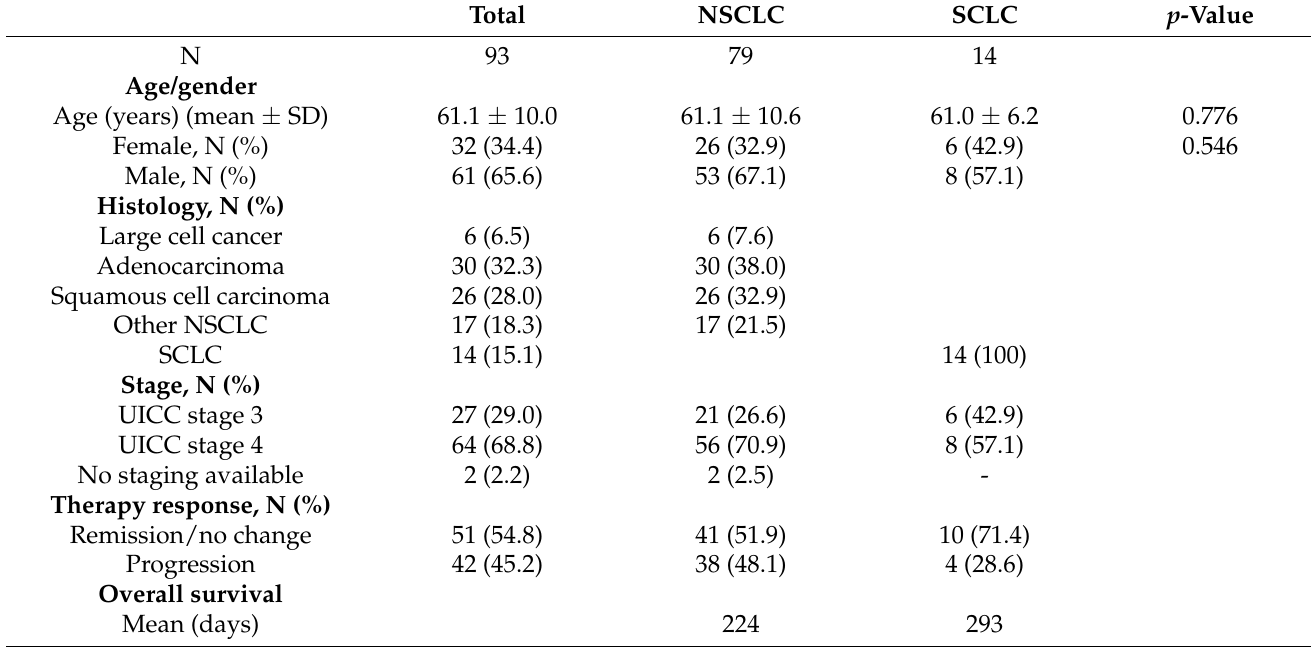
Table 1. Characterization of study cohort. NSCLC: non-small-cell lung carcinoma, SCLC: small-cell lung carcinoma, UICC: union international contre le cancer.